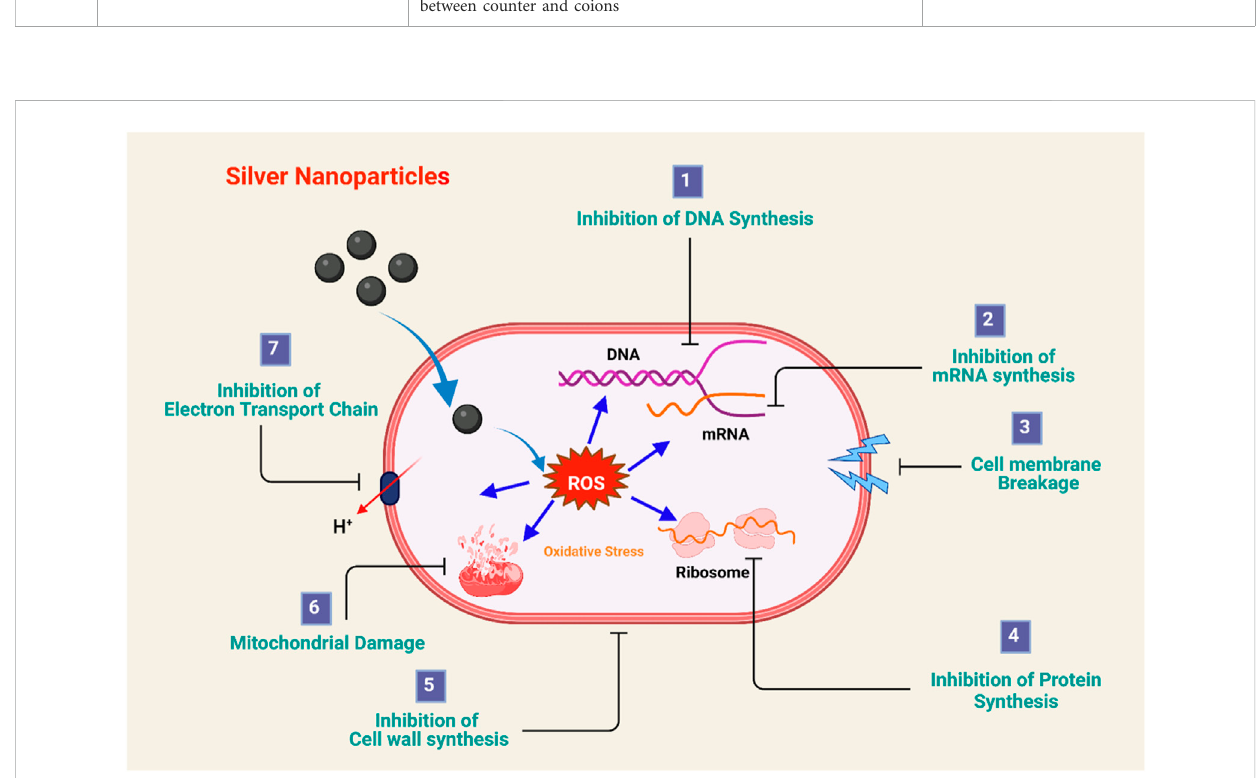
FIGURE 6 Antimicrobial mechanism of silver nanoparticles. Adapted from (Jain et al., 2021) CC BY license.